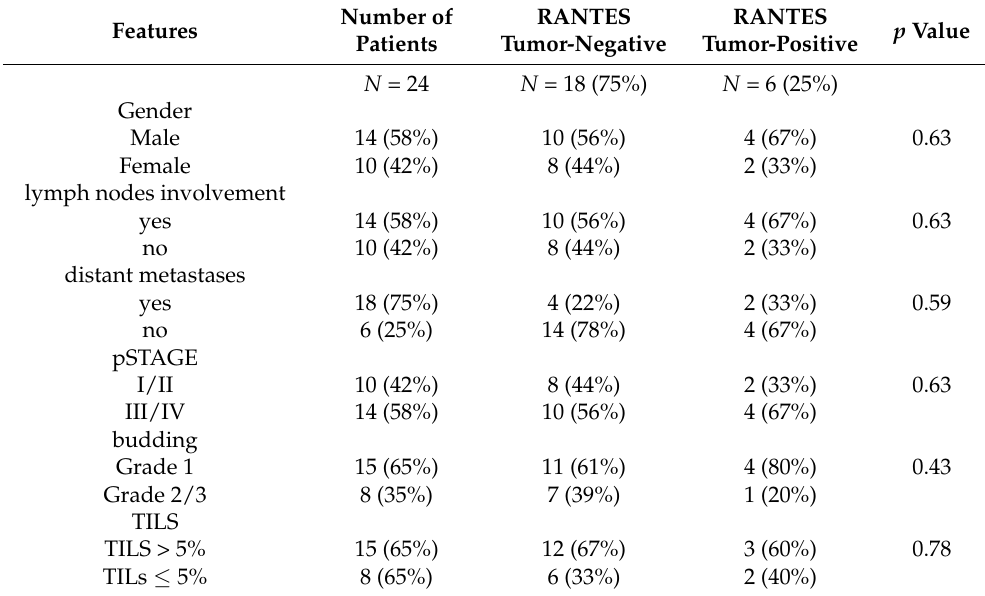
Figure 5. Immunostaining for PD-L1 ((Opta Tech 2200 Camera, magnification 10 × and 60 × ). Cyto- plasmatic positive IHC staining for PD-L1 in tumor-infiltrating lymphocytes. Table 10. Clinicopathological parameters of patients according to RANTES expression in the tumor.